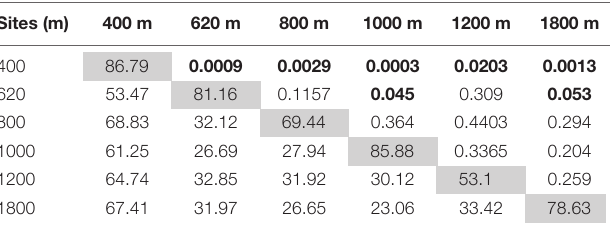
TABLE 3 | PERMANOVA comparisons of meiofaunal assemblages (0–10 cm) along the Costa Rica margin. Sites